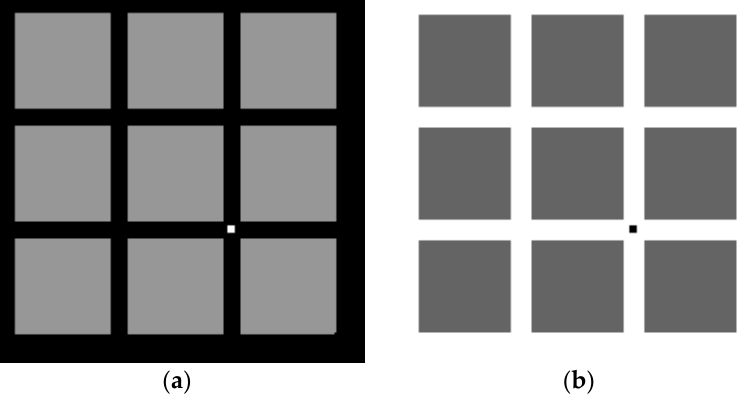
Figure 5. Simulated image with anomaly pixels. ( a ) v b = 0, v o = 150; ( b ) v b = 255, v o = 100.